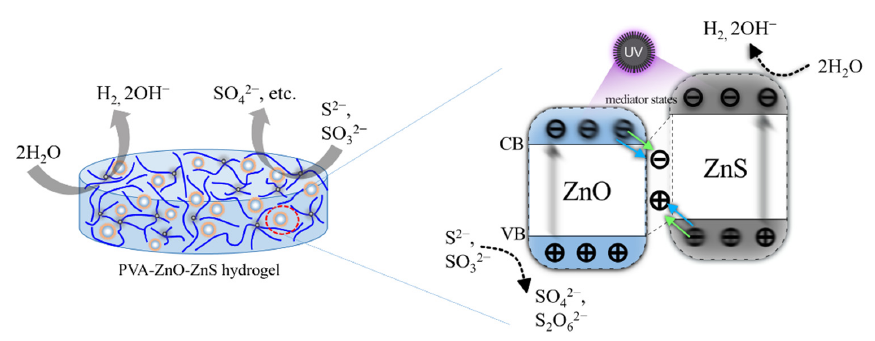
Figure 7. Schematic representation of photocatalytic H 2 -generation by PVA-ZnOS hydrogel from Na 2 S/Na 2 SO 3 solution.